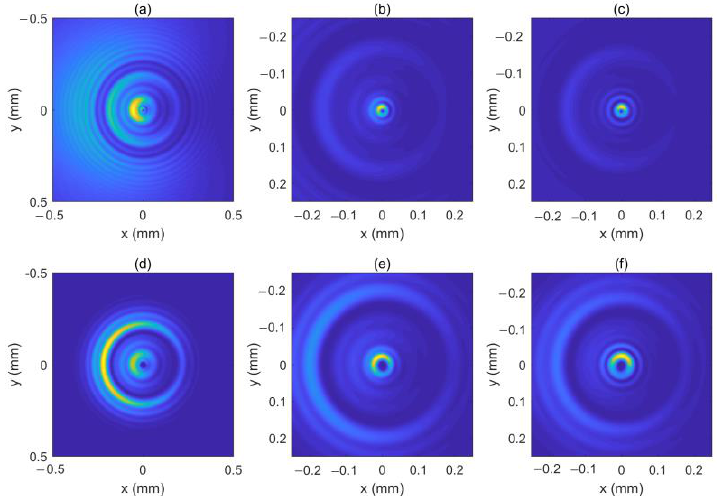
Figure 9. The intensity patterns of the LHCP component ( a – c ) and RHCP component ( d – f ) near the focal plane. ( a , c ), ( b , e ), and ( c , f ) show the intensity patterns for z = 140 mm, z = 145 mm, and z = 150 mm, respectively.